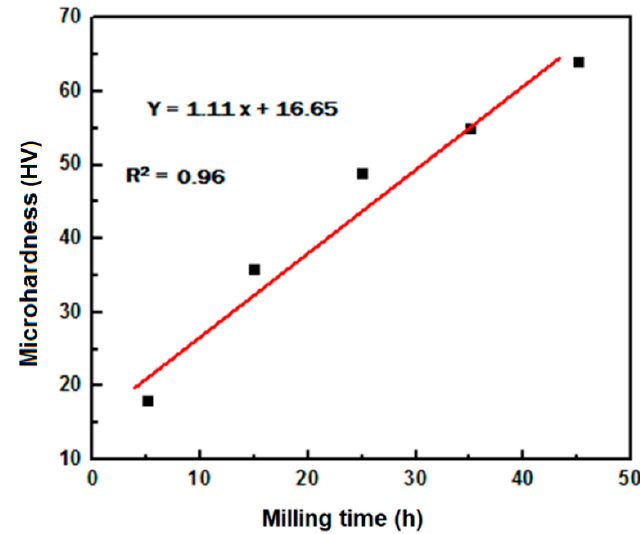
Figure 3. Vickers microhardness of the Sn-0.7Cu alloy as a function of milling time.